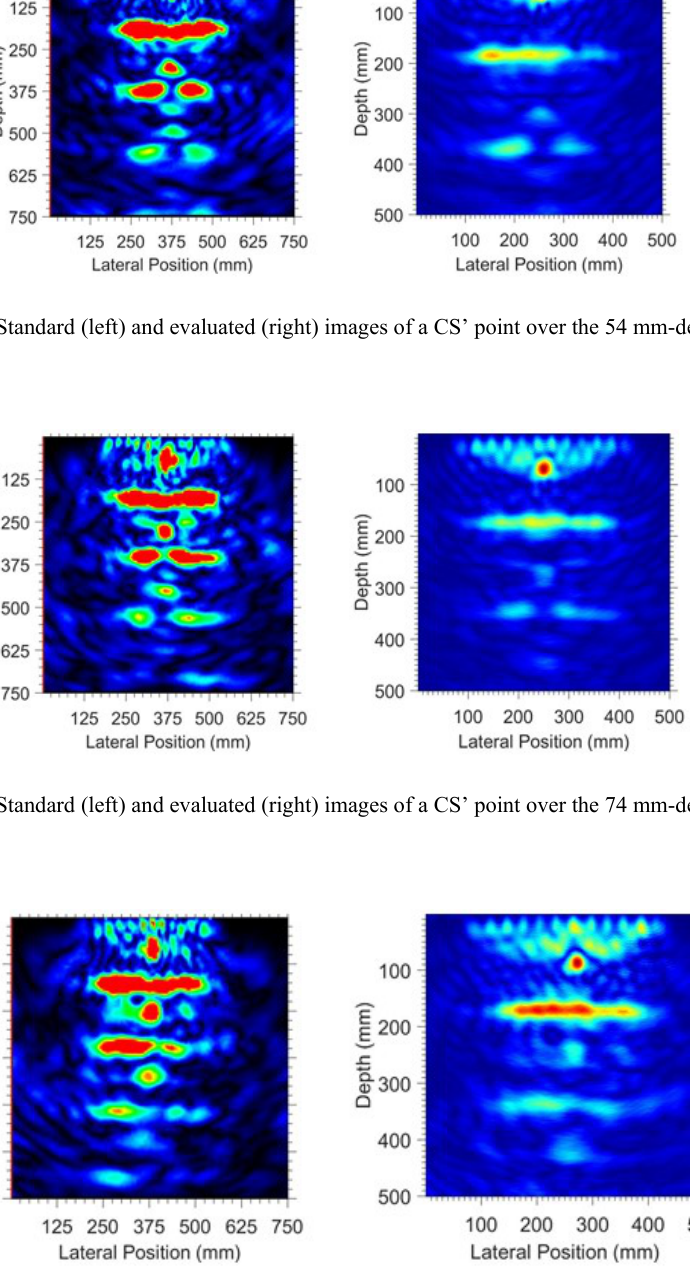
The backwalls should be shown brighter than the dowels since the slab-base course interface’s reflection coefficient is larger than the slab-dowel’s coefficient. Attenuation prevented this in the evaluation images in Figures 4-6. The T -backwall path is larger than the T -dowel path. Hence, the waves striking the backwall have smaller intensity, and the waves reflected at the backwall might have smaller intensity despite the backwall’s larger reflection coefficient. In addition, the waves reflected at the backwall are attenuated to a greater degree on their way to R . As a result of this and the fact that attenuation has not been compensated in the evaluated software, the dowels are shown brighter than the backwall in the evaluated